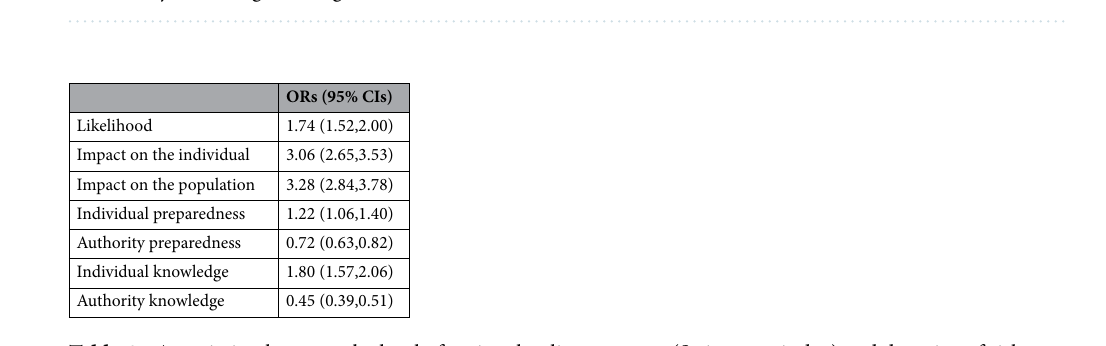
Table 4. Association between the level of national policy response (Stringency index) and domains of risk perceptions. Models adjusted for gender, age and relative